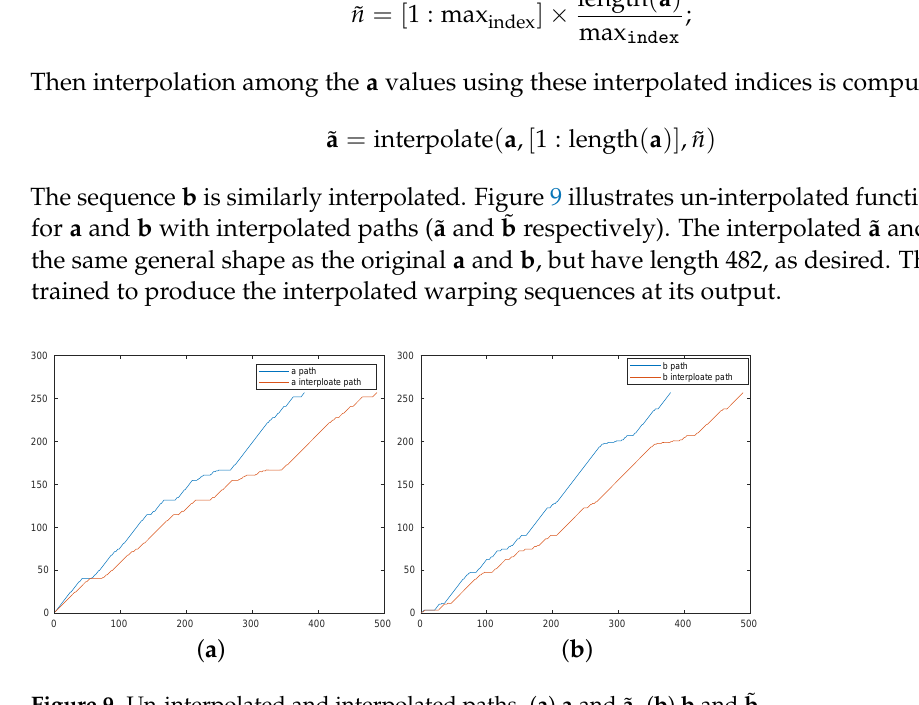
Figure 9. Un-interpolated and interpolated paths. ( a ) a and ˜ a . ( b ) b and ˜ b